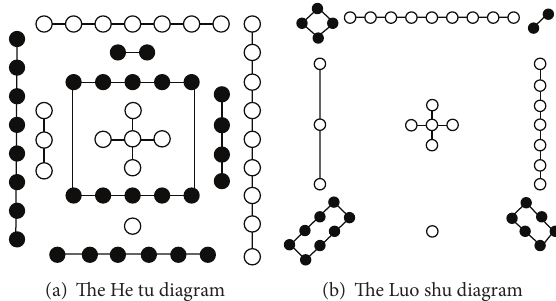
Figure 1: The He tu and Luo shu